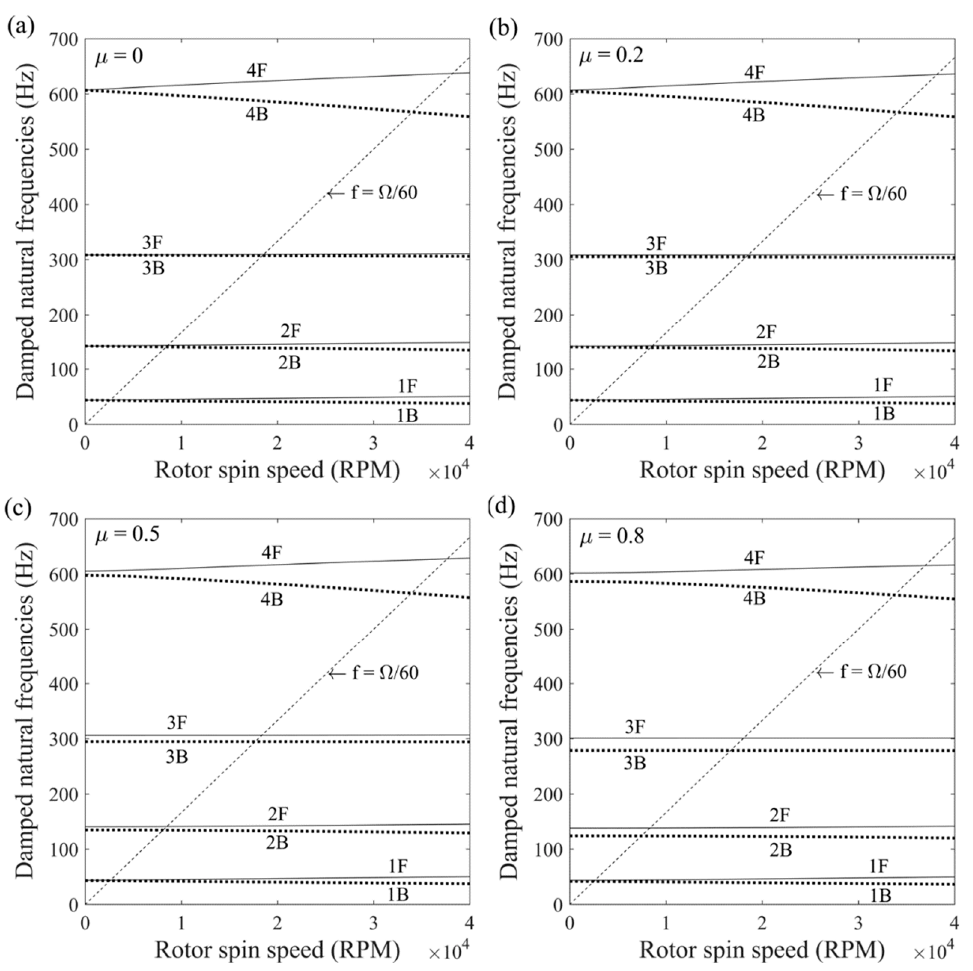
µ = 0, ( b ) µ = 0.2, ( c ) µ = 0.5 and ( d ) µ =